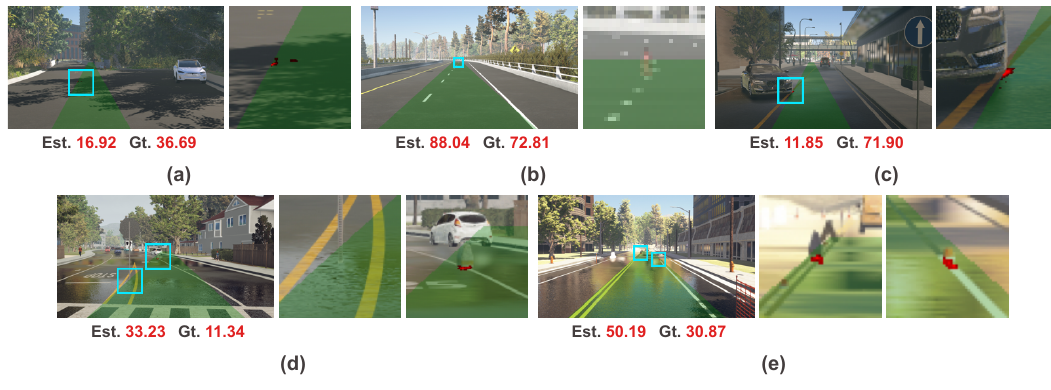
Figure 15. Examples of five types of failure cases of our method. See the text for more